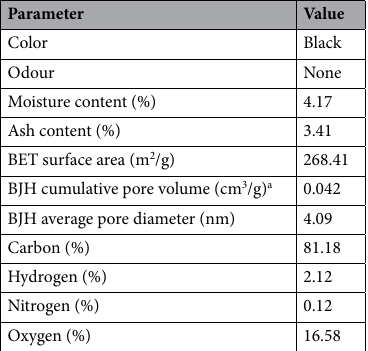
Table 1. Physico-chemical, surface and elemental analysis properties of WAS-BC adsorbent. a Between 1.70- nm and 300.0-nm